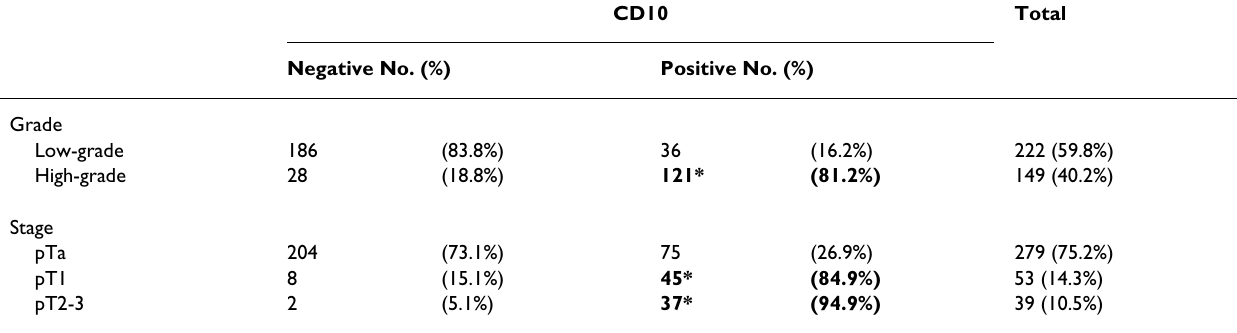
Table 1: Overall CD10 expression according to the histologic grade and pathologic stage